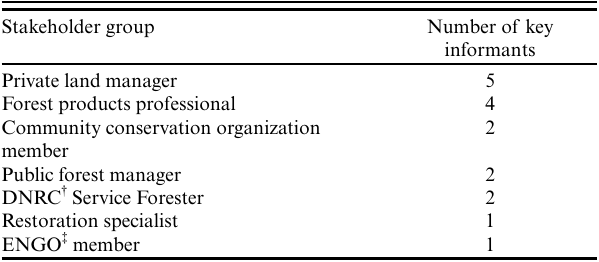
Table 1 . Number of key informants by stakeholder group in the study